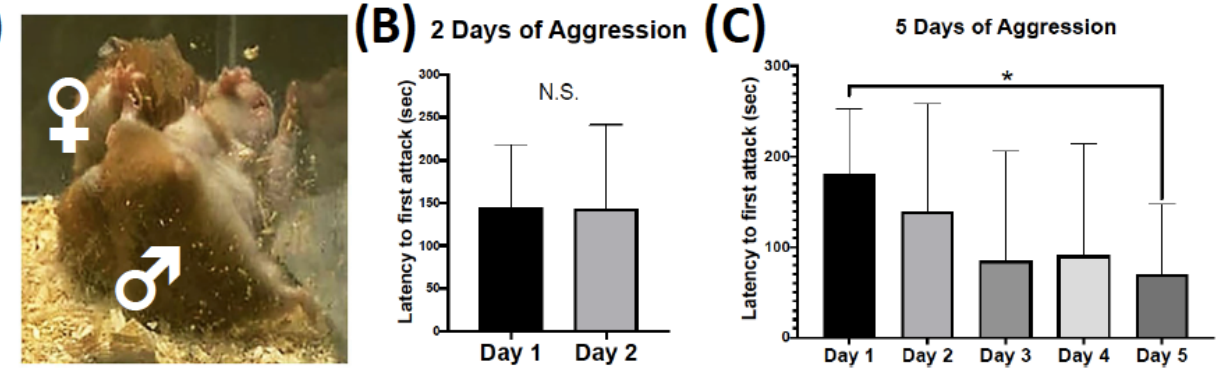
Figure 1. Aggressive behavior over two and five consecutive days of aggressive interactions (5 min each). ( A ) Image of an adult female Syrian hamster biting the lower flank of an intruding adult male Syrian hamster. ( B ) There was no change in the latency to initiate an attack for female Syrian hamsters that experienced two consecutive days of aggressive interactions (non-significant = N.S.) (Days 1–2, n = 11). ( C ) There was a decrease in the latency to initiate an attack for female Syrian hamsters that experienced five consecutive days of aggressive interactions (* p < 0.05). (Days 1–5, n = 9). Data are presented as mean +/ − standard